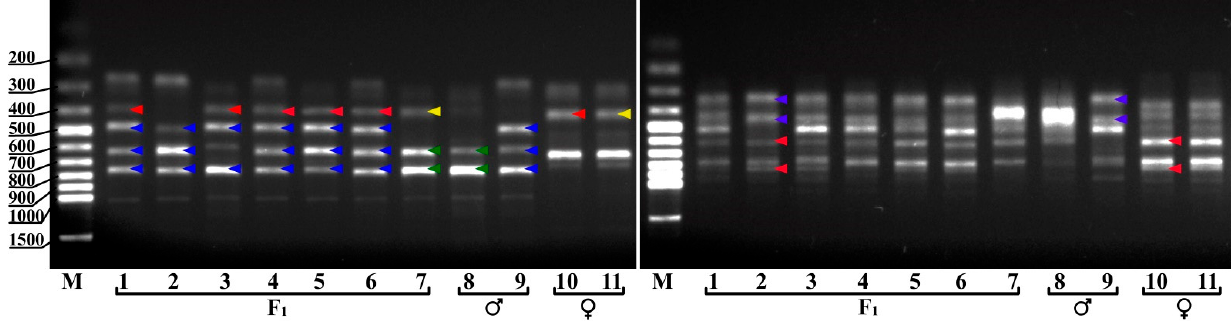
Figure 9. ISSR-PCR eletrophoregrams of genomic DNA with primers UBC825 ( left ) and UBC811 ( right ). 1–6— V.ul. 8 × ‘NC’